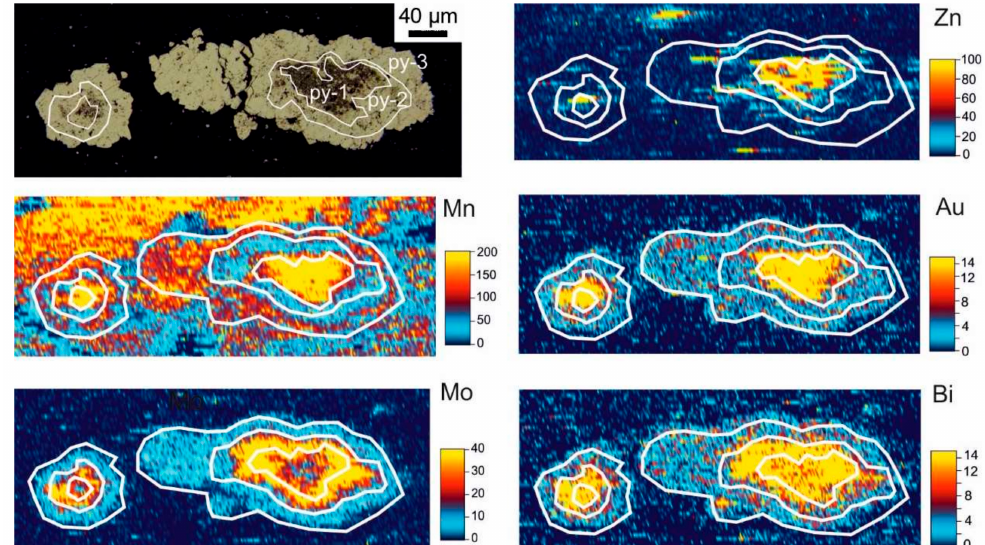
Figure 9. LA-ICP-MS pattern for Zn, Mn, Au, Mo, and Bi of sulfide nodule from sulfide–black shale diagenites of the Saf’yanovskoe